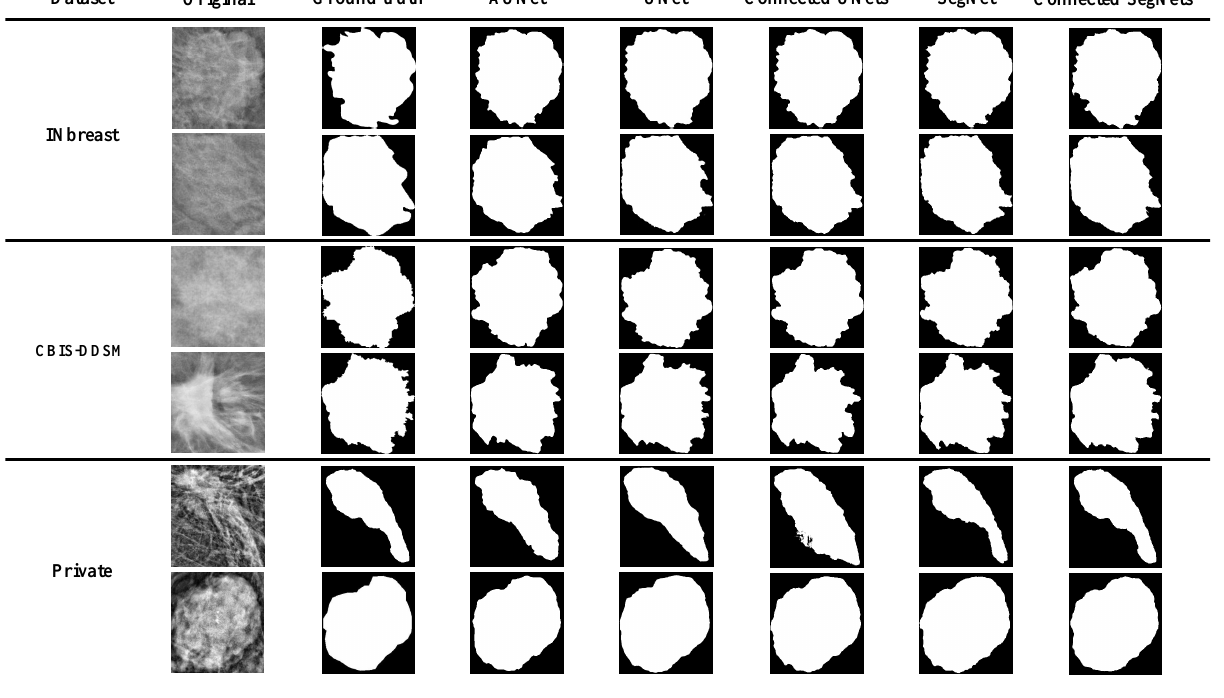
Figure 7. Example of the breast tumor segmentation results using AUNet, UNet, Connected-UNets, SegNet, and the proposed Connected-SegNets on the testing data of INbreast, CBIS-DDSM, and the private